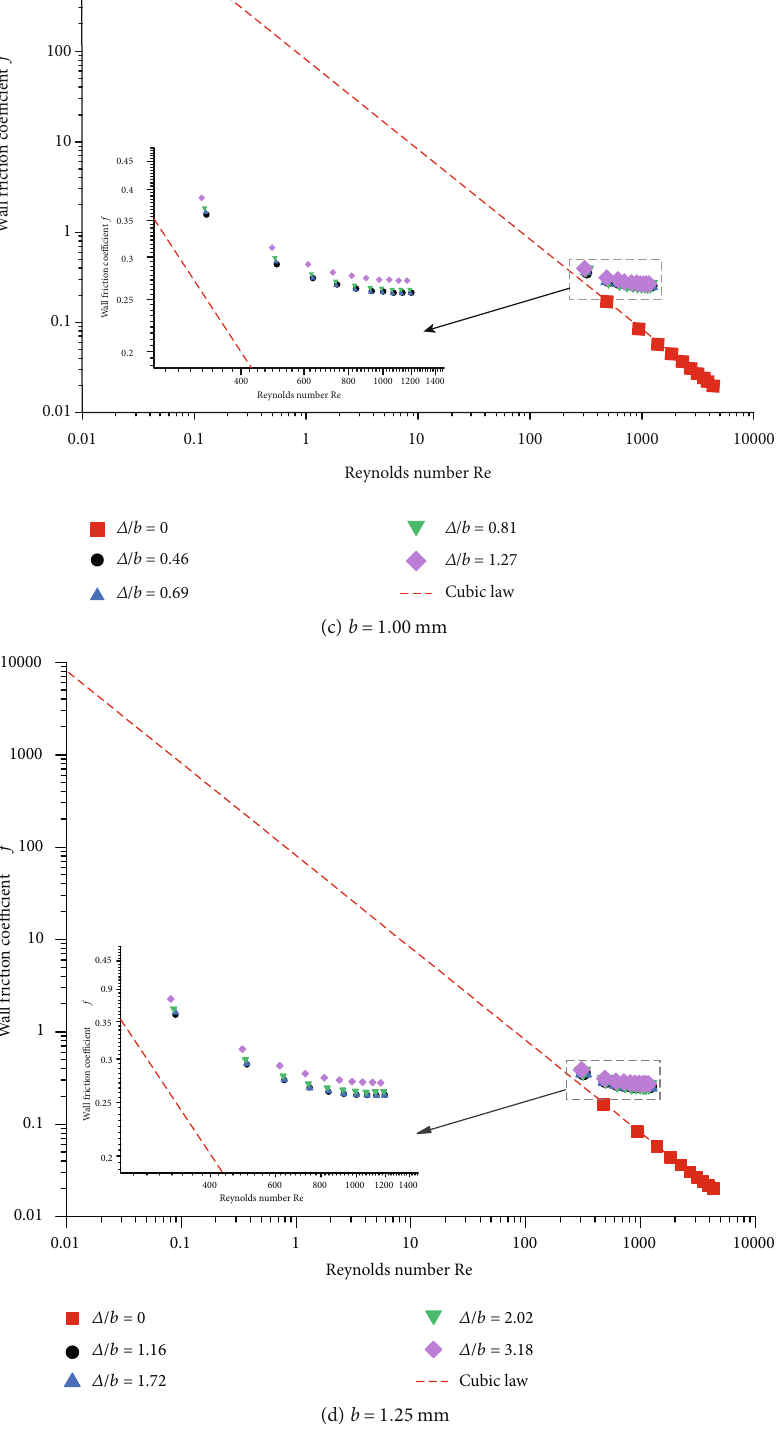
Figure 18: Curves of wall friction factor and